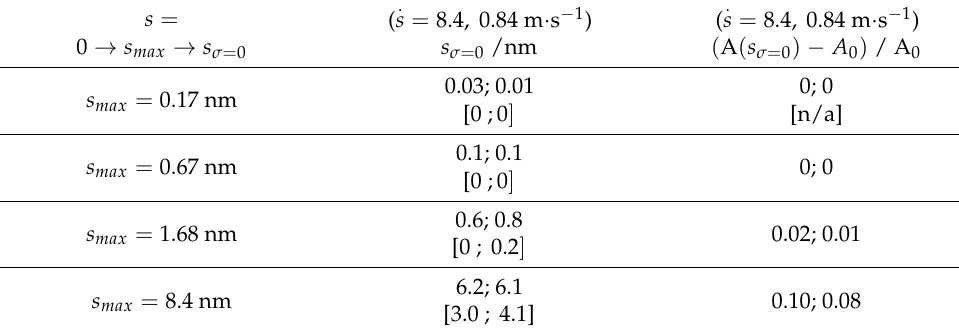
Table 2. Shape changes of the simulation cell as observed from the analyses of the strain reversal runs starting from a variety of epoxy deformation scenarios s max . For this, the profiles of the momentary stress were inspected for vanishing residual stress, and the corresponding elongation s σ = 0 was taken as a measure of plasticity. Data are shown for molecular dynamic runs and constitutive modelling (numbers in square